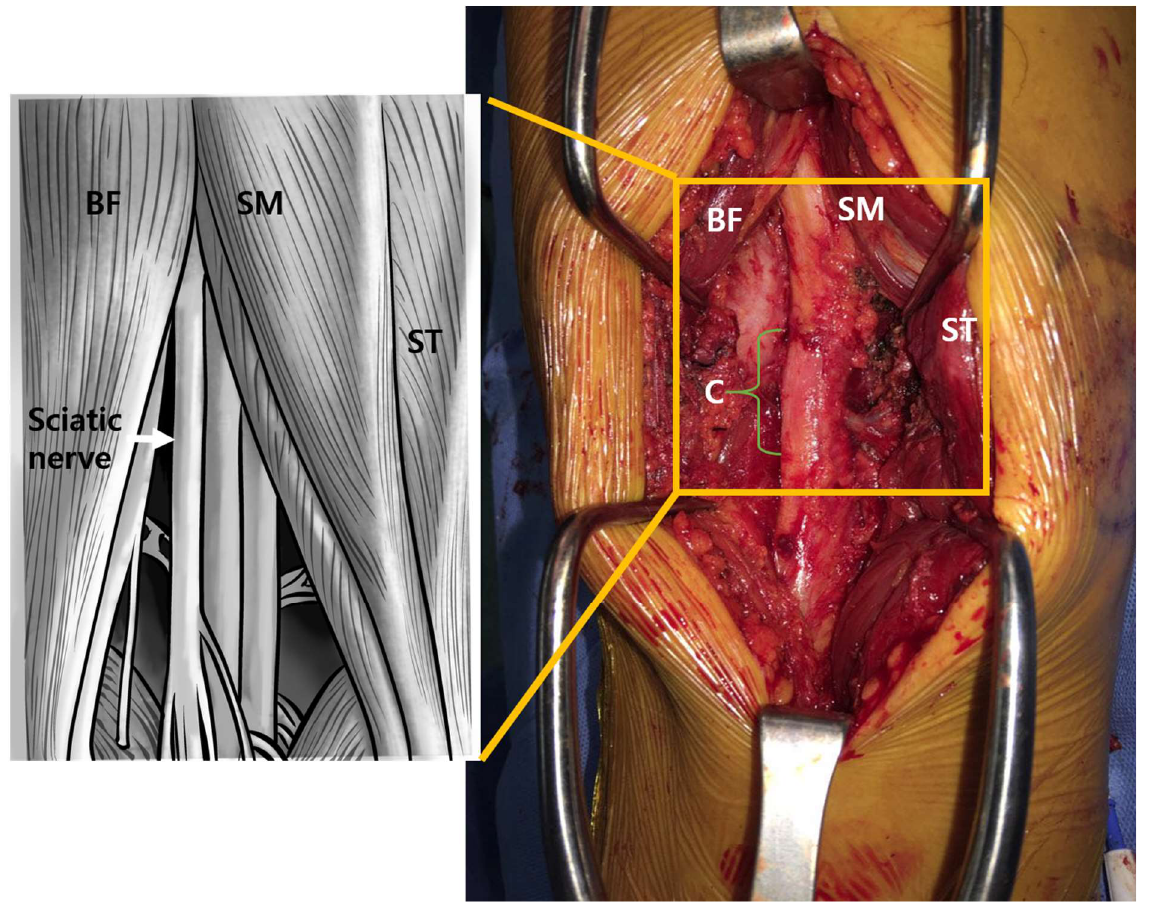
Figure 4. The intraoperative gross photo shows a severely compressed lesion of the sciatic nerve (green bracket). BF: Biceps femoris. SM: Semimembranosus. ST: Semitendinosus.